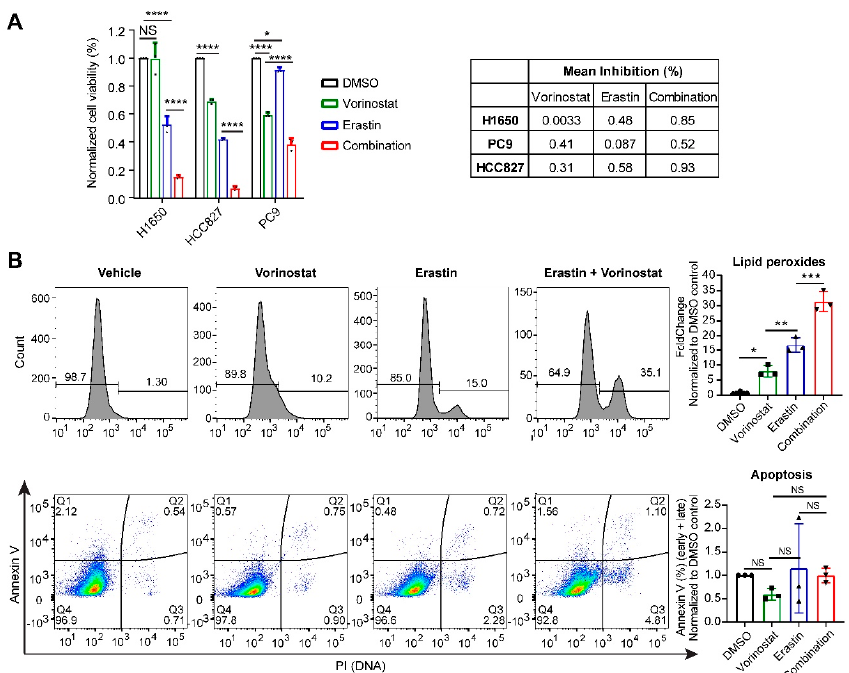
Figure 2. HDAC (histone deacetylase) inhibition enhances antitumor efficacy of a ferroptosis inducer in lung cancer cells. ( A ), Non-small cell lung cancer cells (H1650, HCC827, PC9) were treated with Vorinostat (HDACi; 1 µM), Erastin (1 µM), alone and in combination (Vorinostat [1 µM] plus Erastin [1 µM]) for 72 h. Cell viability was quantified by counting cell number. ( B ), Flow cytometry-based analysis of lipid peroxides (upper panel) and apoptosis (middle panel) in H1650 cells treated for 24 h with Vorinostat [1 µM], Erastin [1 µM] and alone and in combination. Representative figures (upper and middle panels) and their quantification (lower panel) were shown ( n = 3 biological repeats). PI: Propidium iodide. * p < 0.05, ** p < 0.01, *** p < 0.001, **** p < 0.0001 by one-way ANOVA ( n = 3).